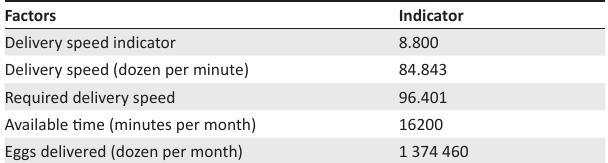
TABLE 13: Delivery speed.